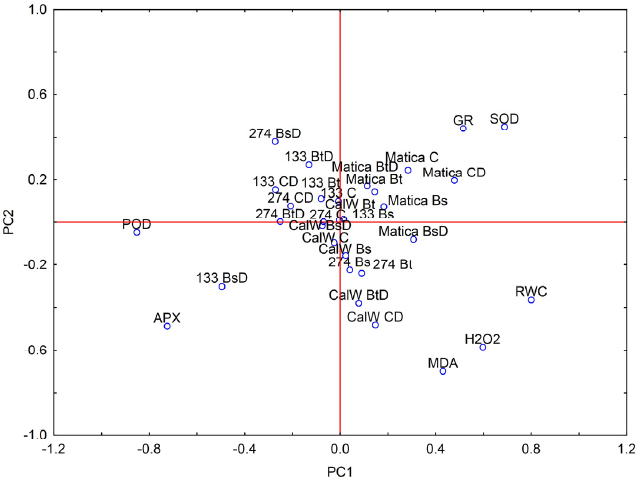
Figure 6. Principal component analysis (PCA) biplot of evaluated traits among four pepper genotypes in control (C) and drought (D) conditions treated with two bacterial strains, B. safensis SS-2.7—Bs and B. thuringiensis